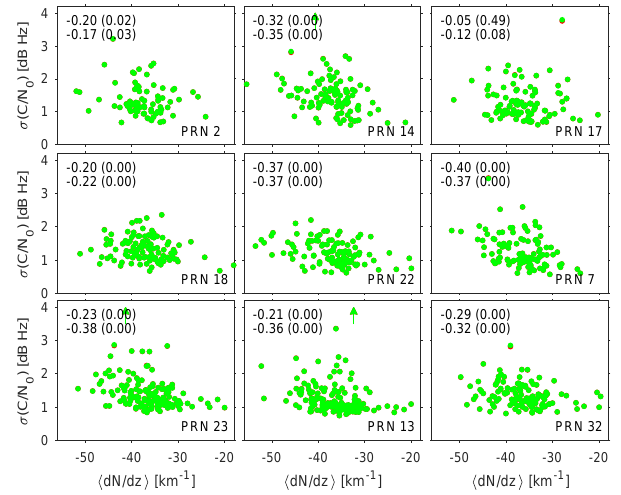
Figure 15. Standard deviation of C /N 0 at elevation angles be- tween + 1 and + 2 ◦ versus mean refractivity gradient for nine PRNs extracted from ECMWF (March to mid-July 2014). For PRN 13, 14 and 23 one data point exceeds the axis limit of 4 . 2dBHz; its respective mean refractivity gradient is marked by an arrow. (Of course, these observations are included in the statistical analysis.) In the upper left corner of each panel correlation coefficients are given (top: Pearson’s coefficient; bottom: Spearman’s coefficient). The corresponding significance parameters are stated in brackets. Results from O/L channel B (green points) very closely agree with channel A data (red) and therefore almost completely mask the lat- ter.